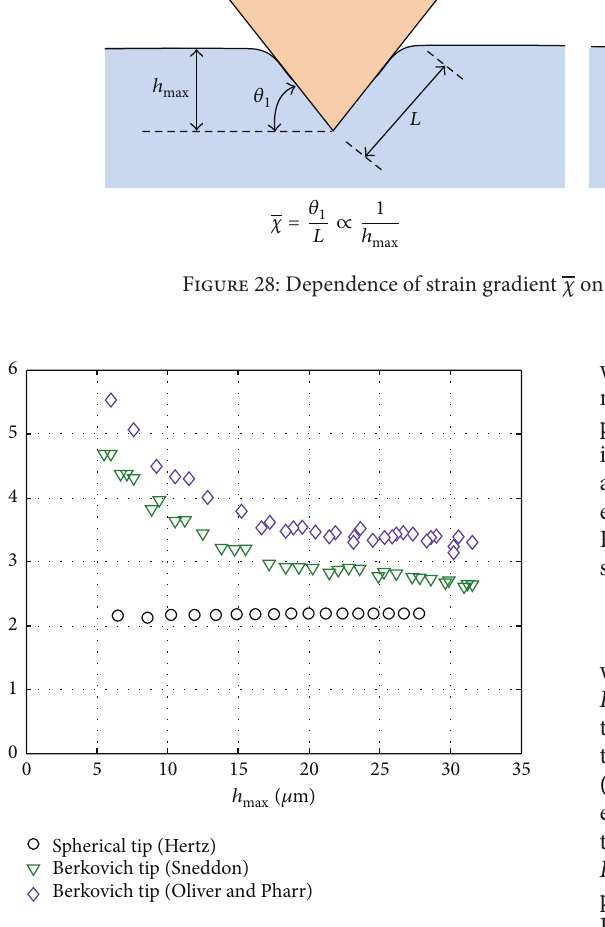
Figure 29: Elastic modulus of PDMS [59] determined with loading and unloading times of 80s (without holding